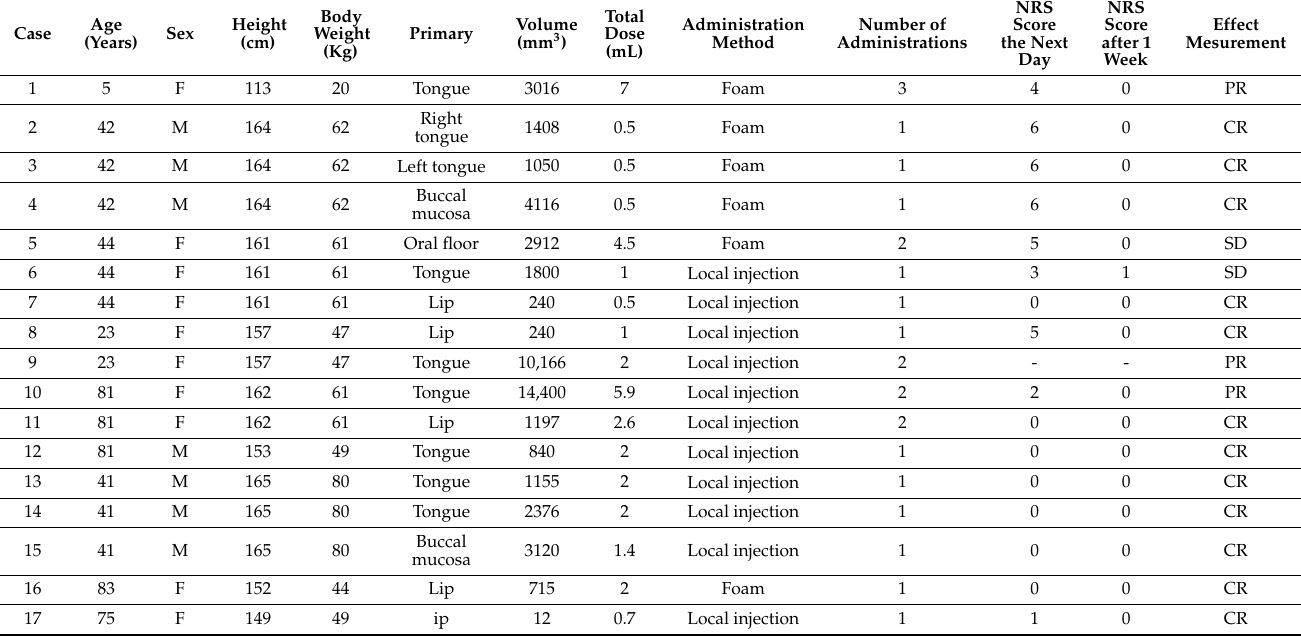
Table 1. Summary of study